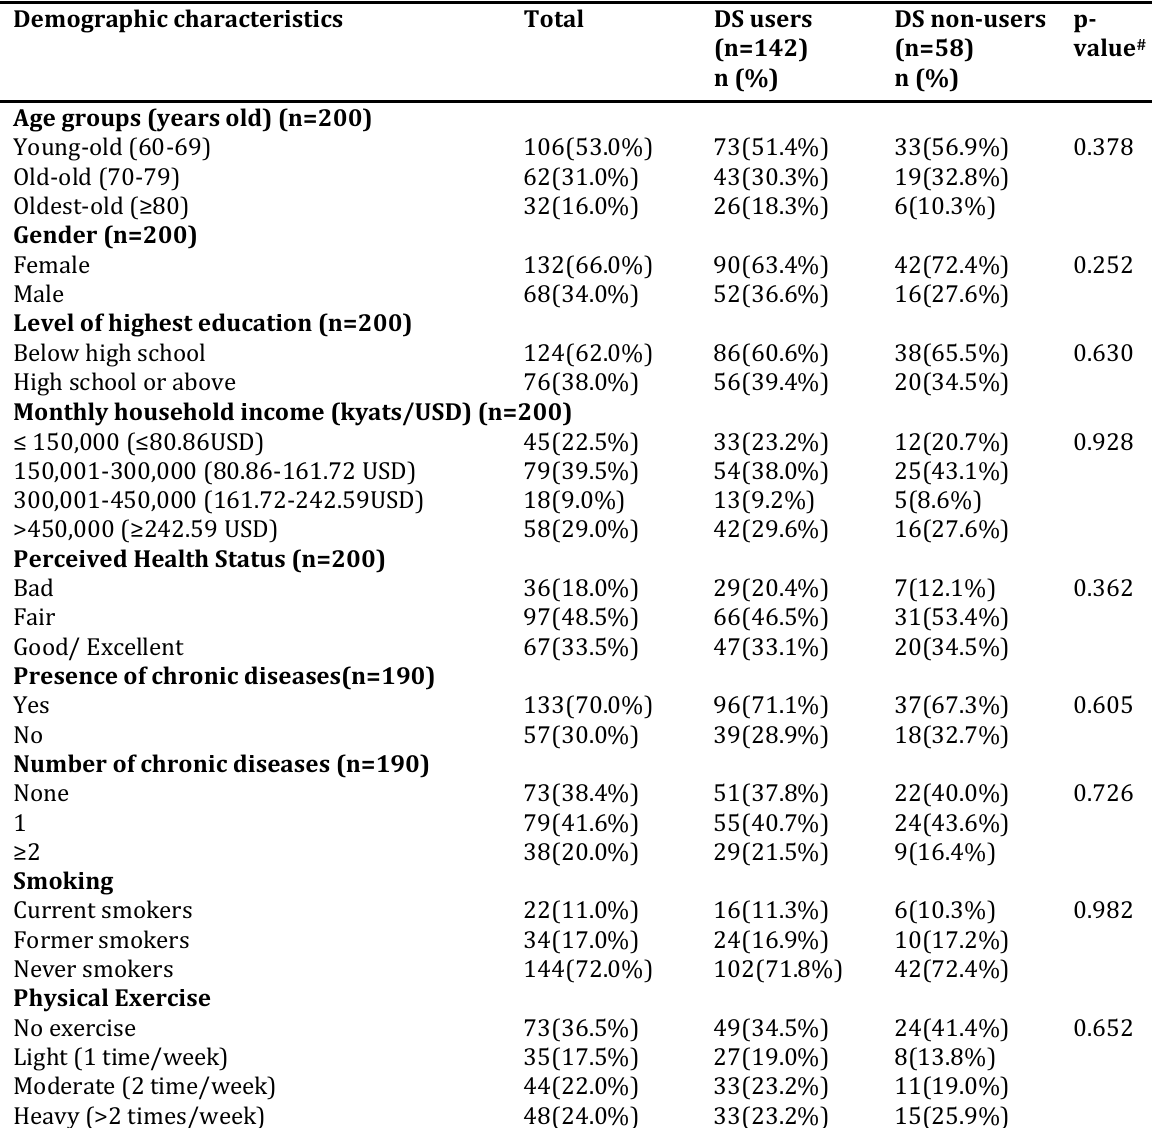
Table 1: Demographic characteristics differences between DS users and non-users Demographic